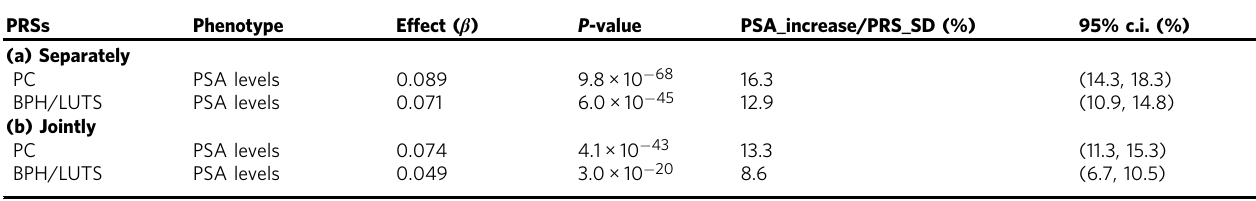
Table 2 Results from testing the association between polygenic risk scores based on UK data, and a phenotype status, based on Icelandic